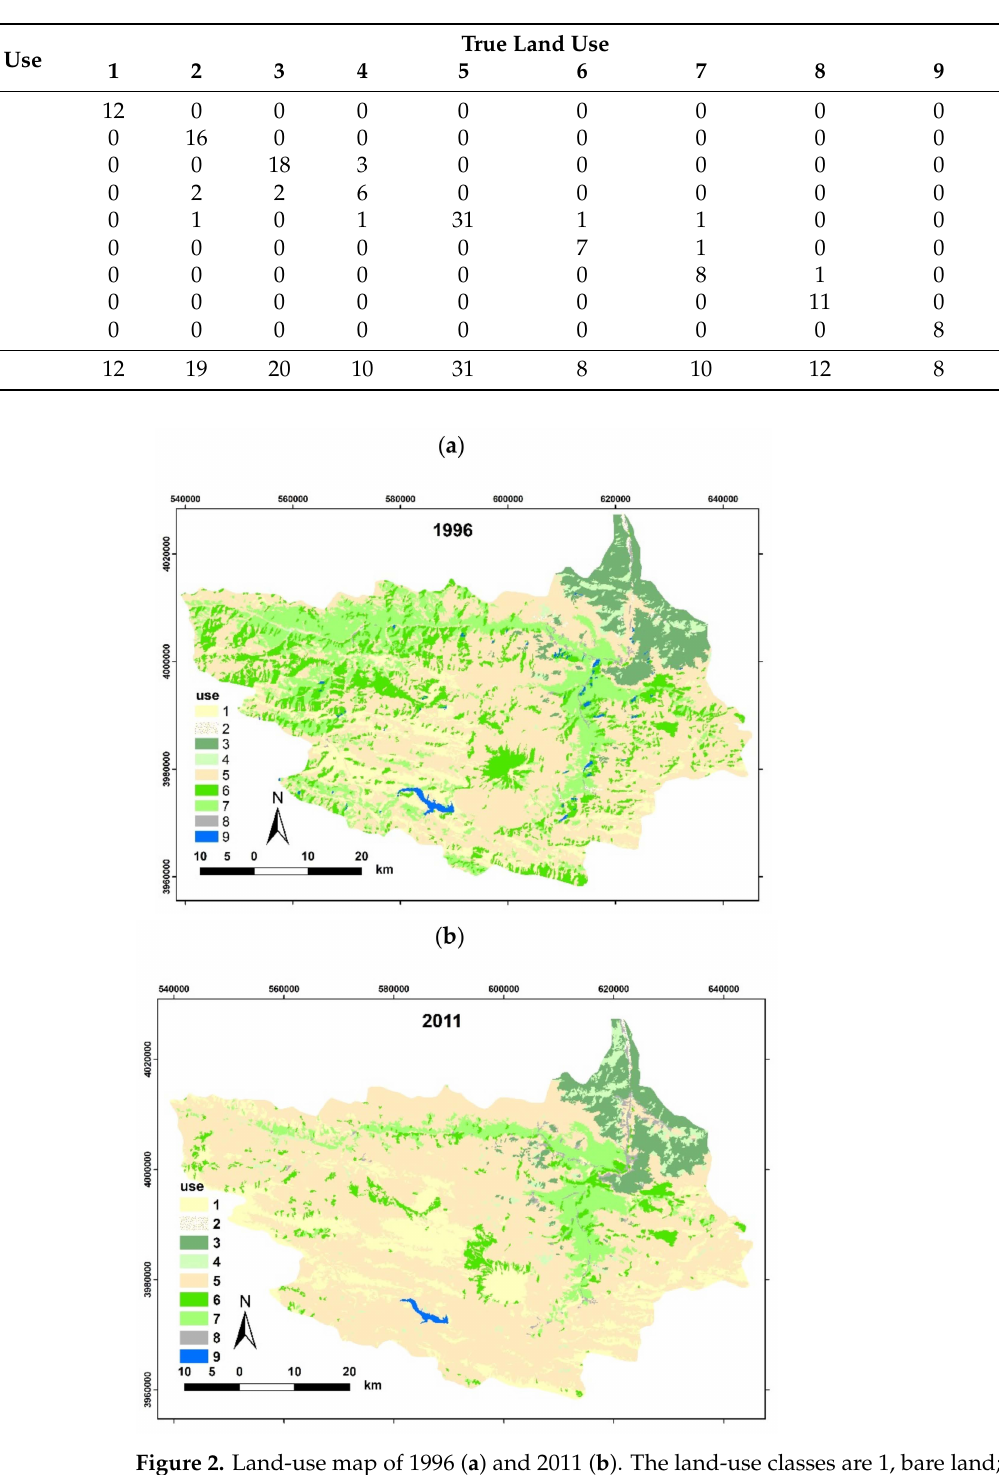
Table 2. Accuracy of the classification of the 2011 image. The classes were: 1, bare land; 2, irrigated farming; 3, dense forests; 4, sparse forests and horticulture; 5, rangeland and dry farmin;, 6, first-grade range; 7, second-grade range; 8, residential; 9, water.